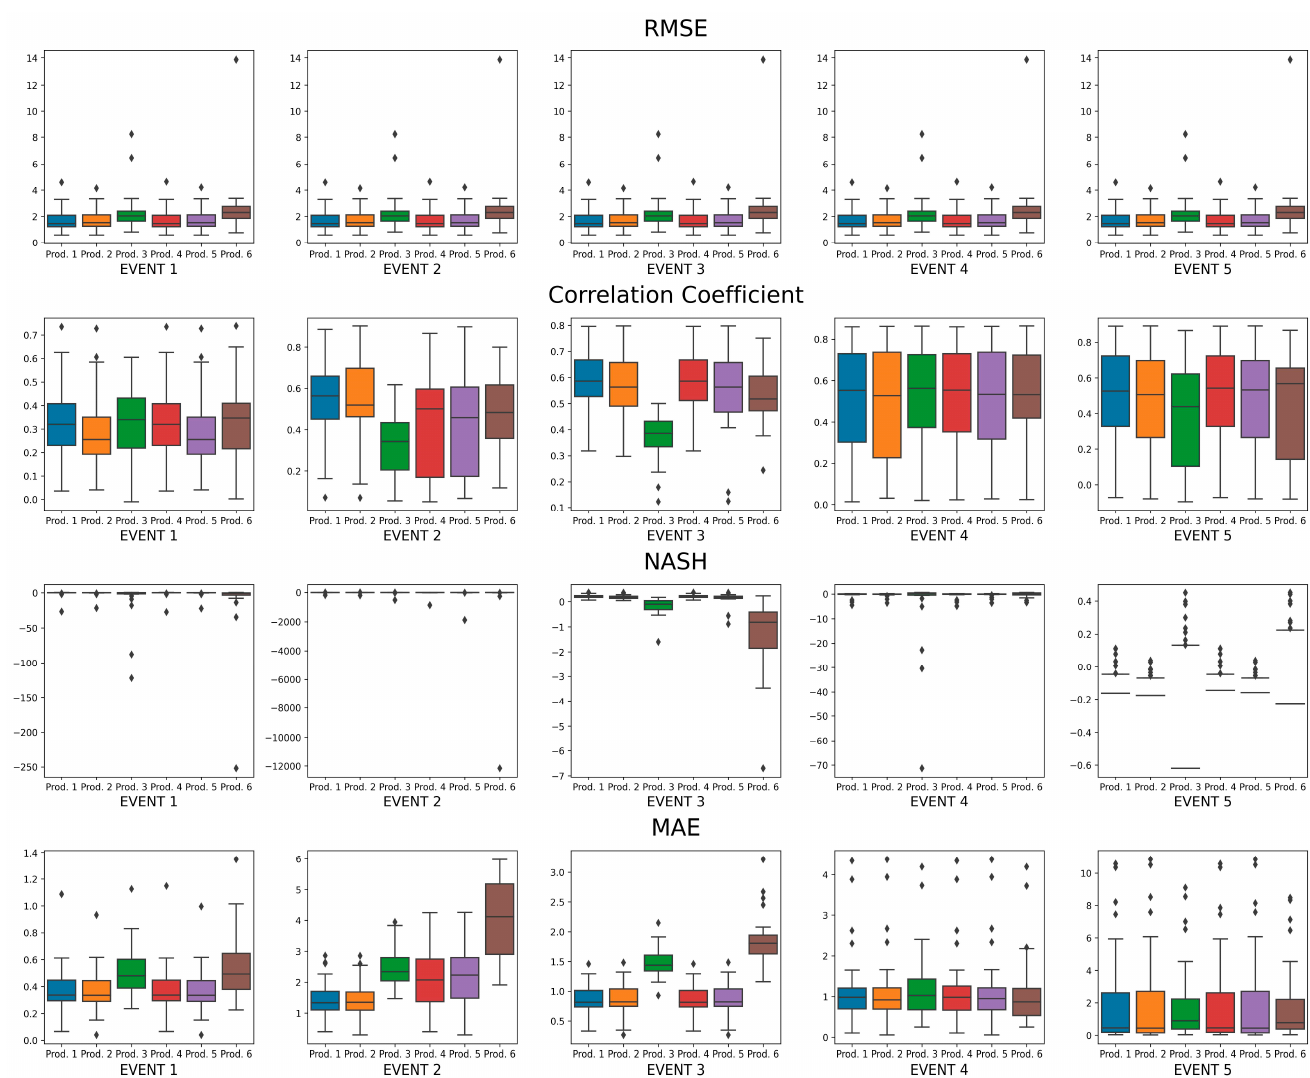
Figure 7. Statistical indices (RMSE, Pearson correction coefficient, Nash–Sutcliffe efficiency, and mean absolute error) of the comparisons for Events 1, 2, 3, 4, and 5 between rain gauge results and Guaratiba’s six S-band radar products using 𝑍 (cid:3035)(cid:2870) at radar pixels where rain gauges are located.